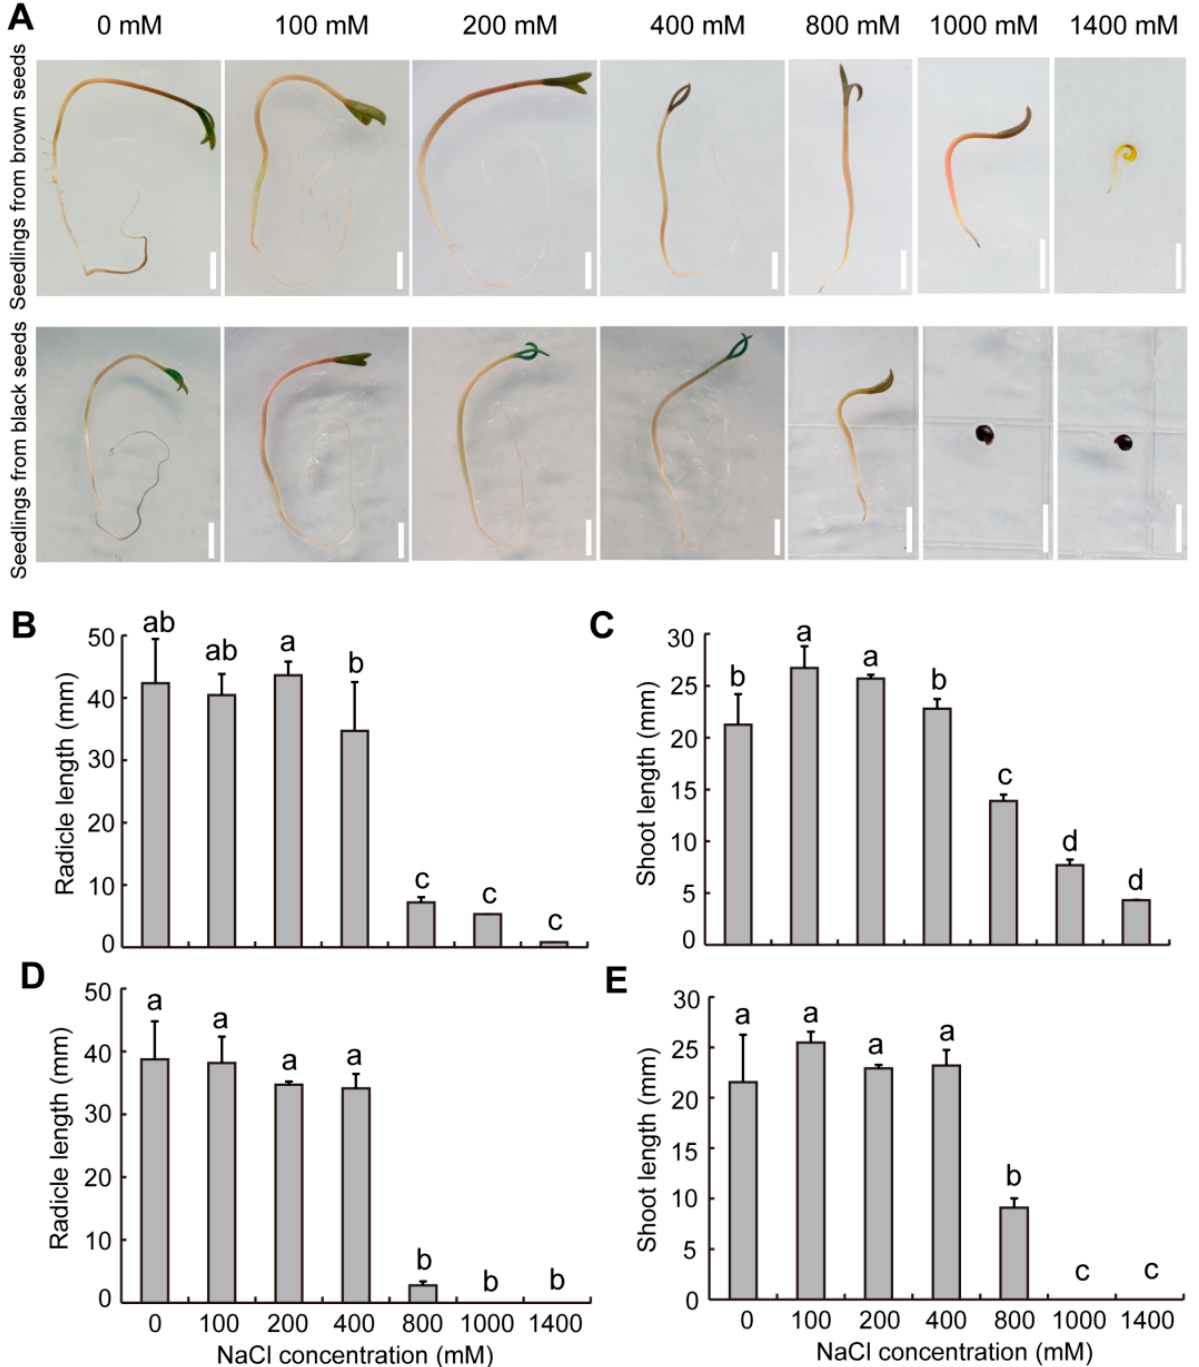
Figure 7. Effect of NaCl on the growth of seedlings from dimorphic seeds of S. liaotungensis . ( A ) Seedlings from dimorphic seeds under different NaCl concentrations’ treatment. Bars = 5 mm. ( B , C ) Radicle and shoot lengths of seedlings from brown seeds. ( D , E ) Radicle and shoot lengths of seedlings from black seeds. There were 10 seedlings counted for each replicate. Different letters show significant differences (LSD test, p < 0.05).